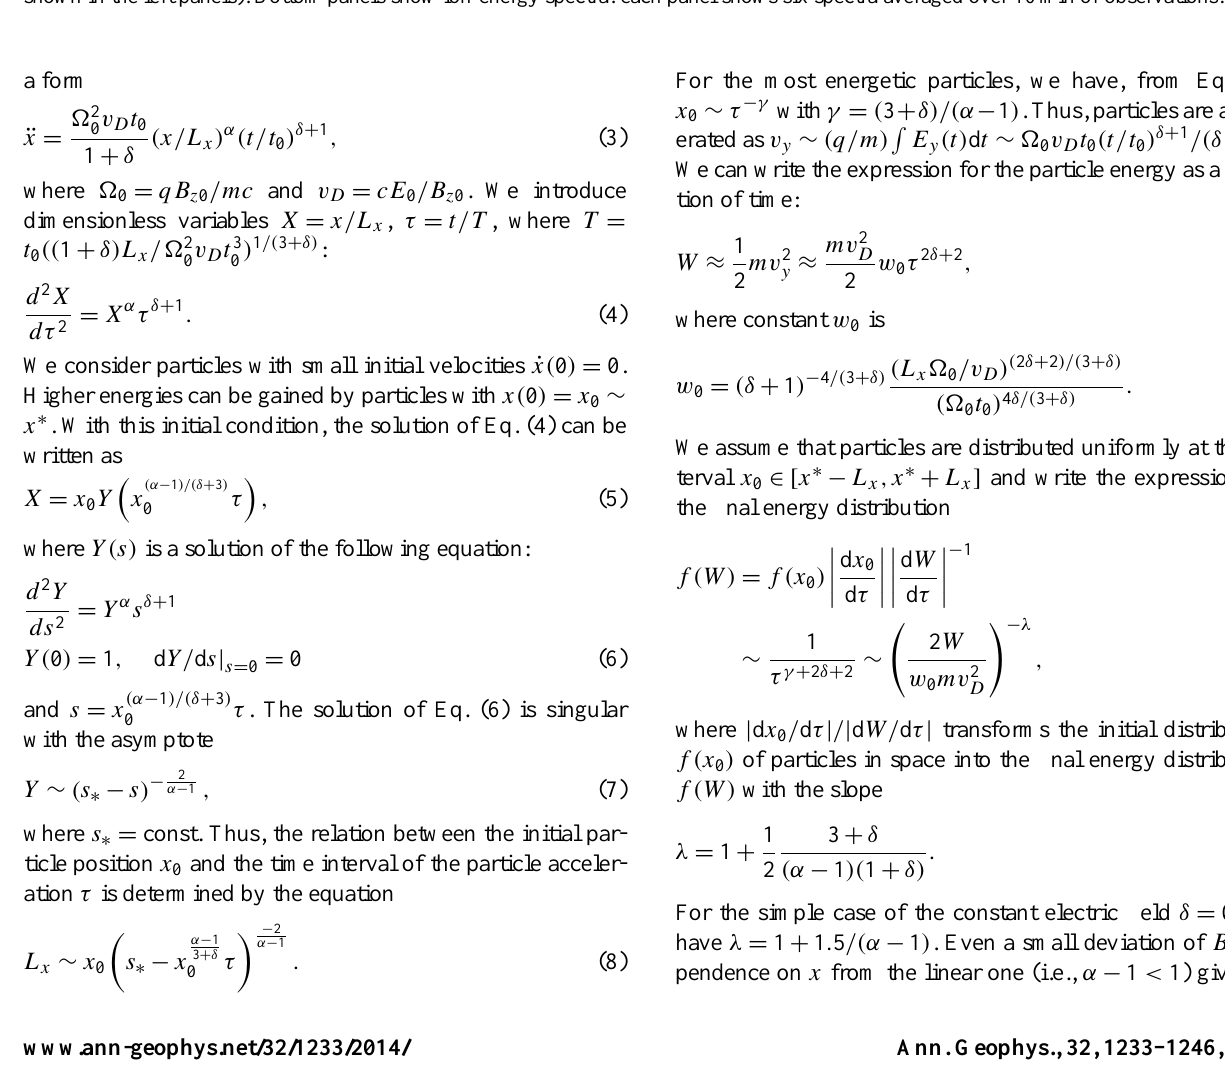
Figure 6. Two cases of observations of high-energy ion spectra in the magnetotail. Top panels show two components of the magnetic field in the GSM coordinate system. Middle panels show ion bulk velocities and temperatures ( v y component was measured only for the event shown in the left panels). Bottom panels show ion-energy spectra: each panel shows six spectra averaged over 10min of